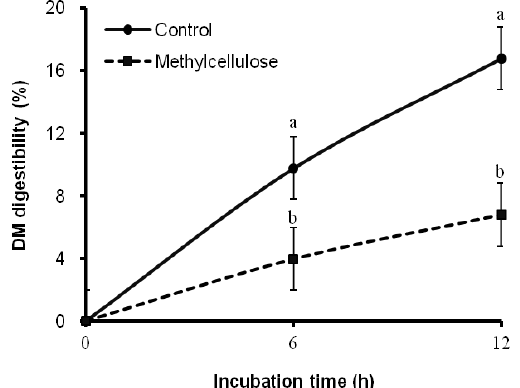
Figure 8. Attachment of Ruminococcus flavefaciens as influenced by rice straw pre-treatment with MC (methylcellulose). a,b Means with different letters differ significantly (p<0.05).